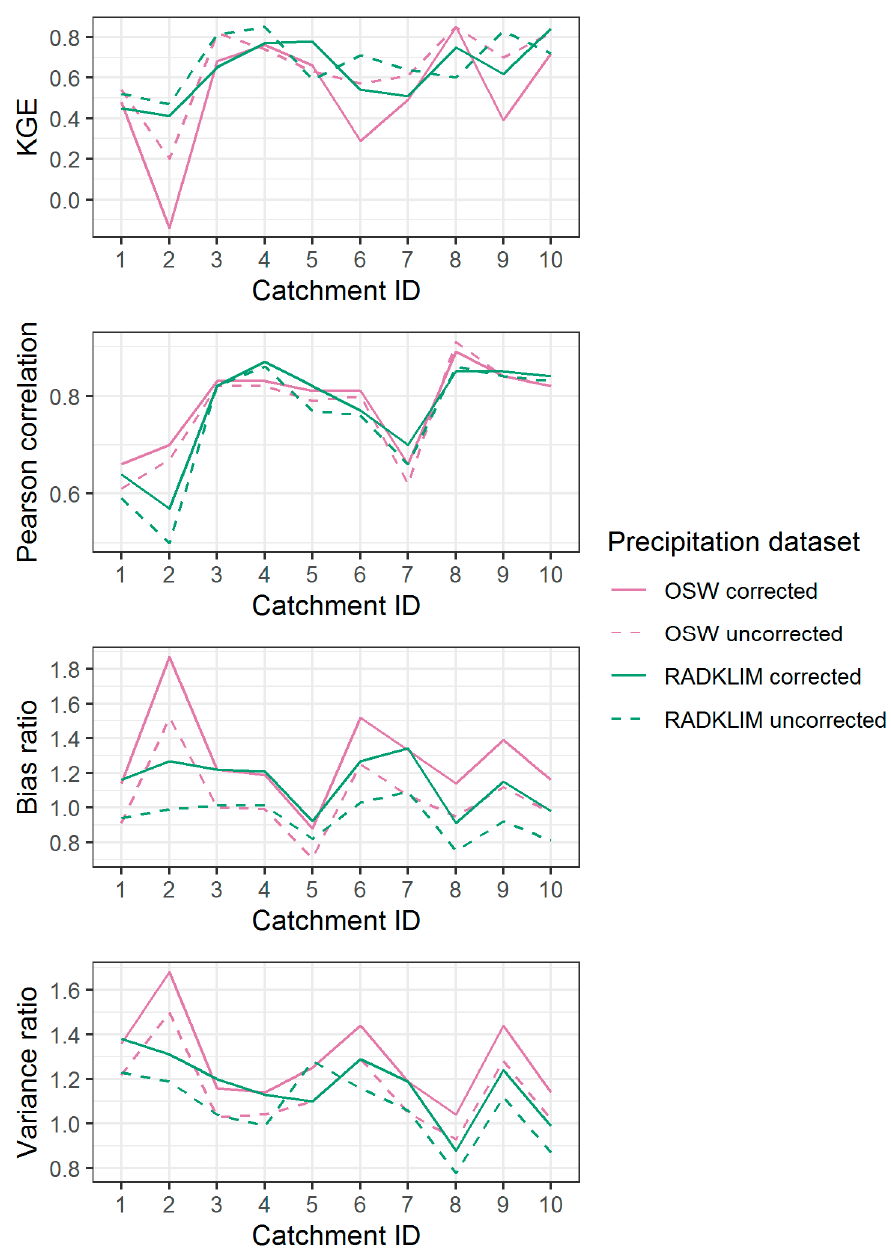
Figure 11. Skill scores of observed and simulated discharge with different precipitation data inputs for the ten selected catchments on a monthly scale.